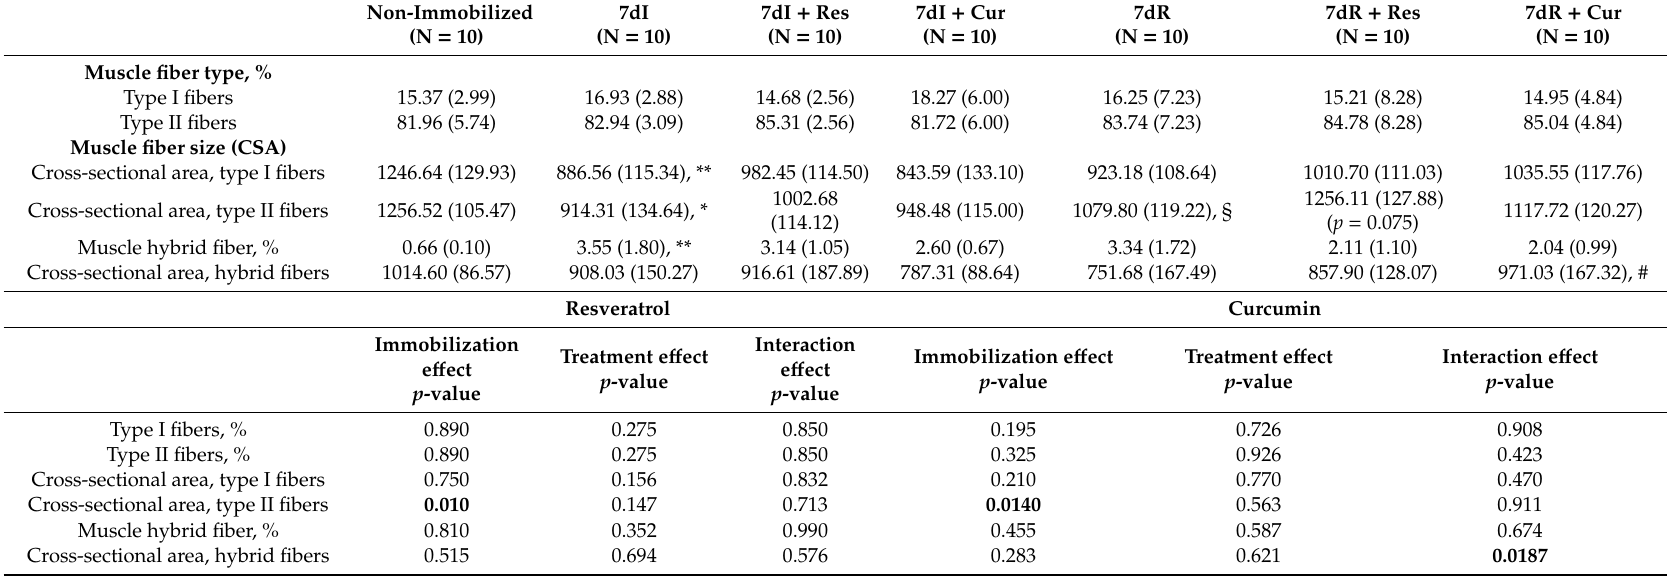
Table 2. Structural characteristics of the gastrocnemius muscle in the study